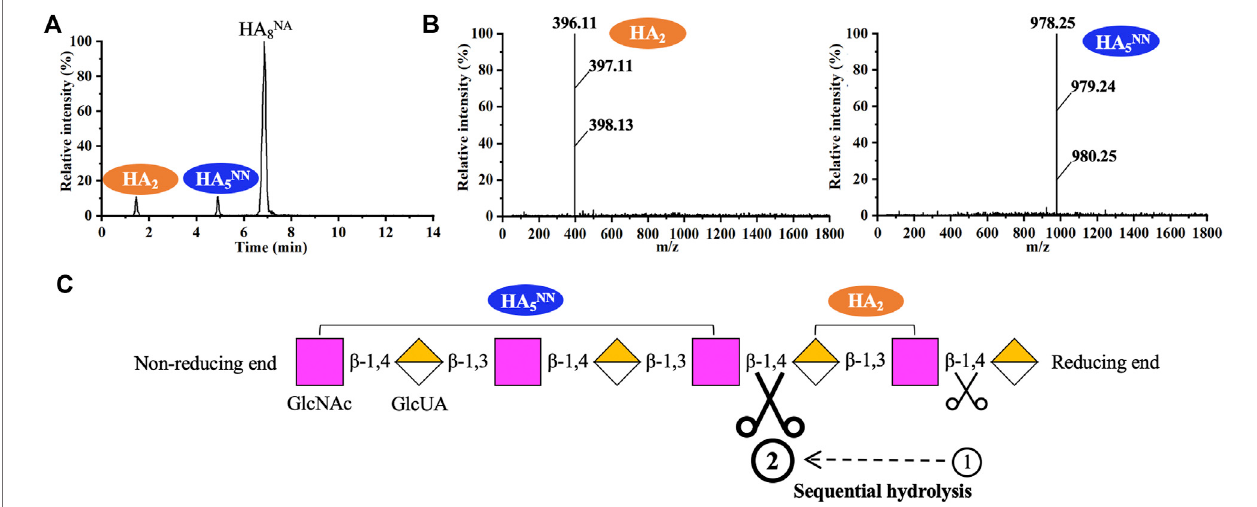
FIGURE6| Analysisoftheend productsofHA 8NA hydrolyzedbyrecombinant hPH20. (A,B) Extracted ionchromatogram/massspectraofendproductsofHA 8NA by HPLC-MS. (C) Schematic diagram of the hydrolysis process of HA 8NA .